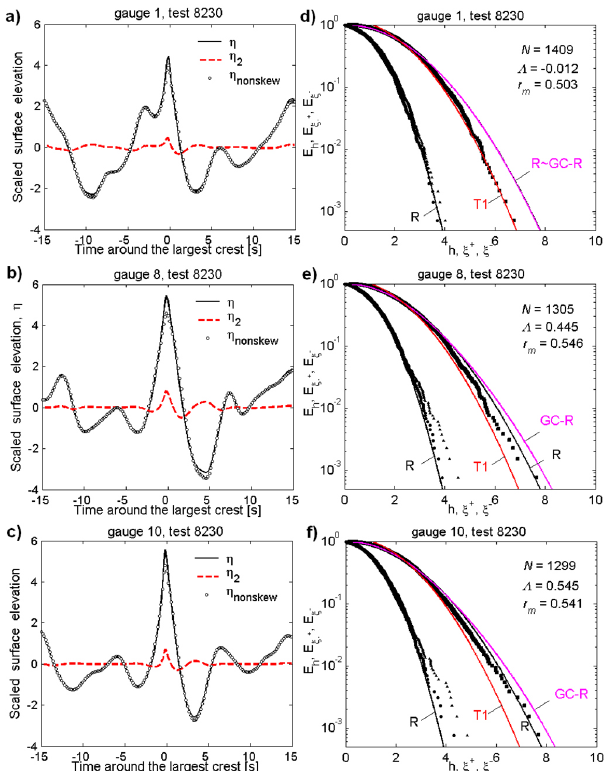
Figure 12. (a–c) Non-linear surface profile around the largest crest (thin line), second-order corrections (dashed line) and non-skew profile (circles); (d–f) distributions of crests, troughs and heights extracted from the non-skew surface